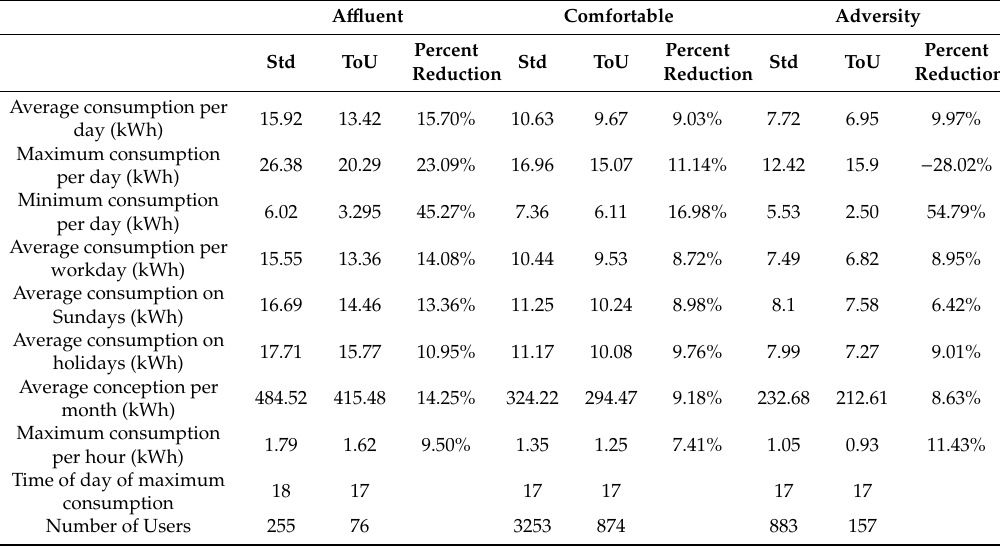
Table 3. Data summary of average energy consumption per grouped categories and tariff program for 2013. A ffl